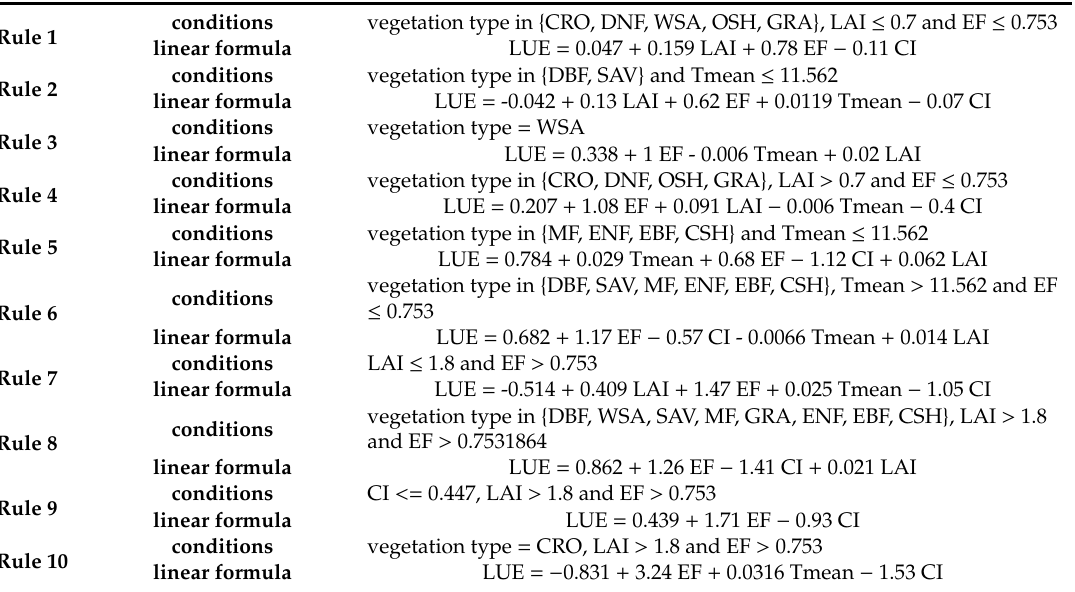
Table 2. Cubist regression tree